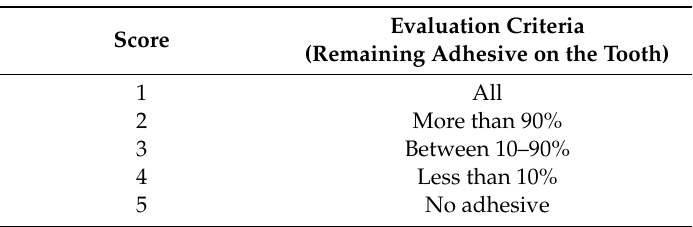
Table 1. ARI score